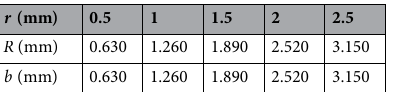
Table 3. Specifications for basic droplet